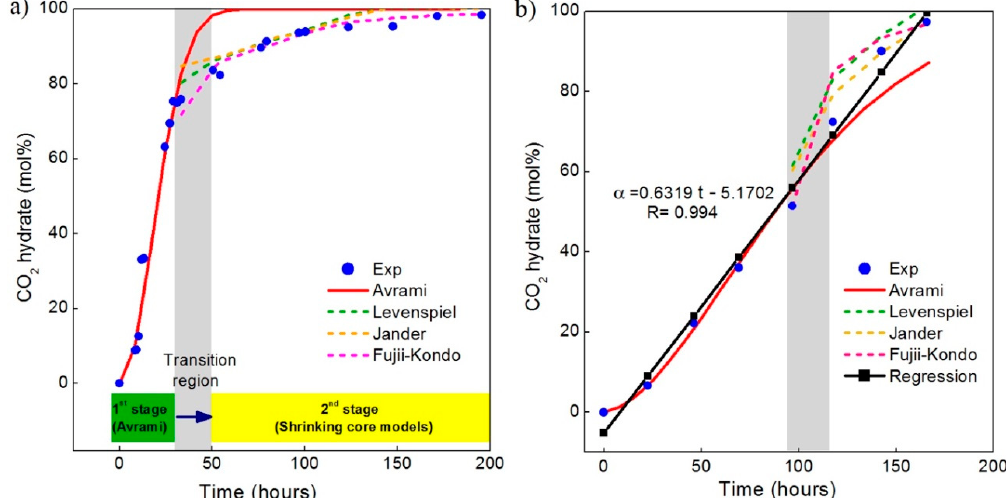
Figure 11. Comparison of the Avrami (solid line) and shrinking core models (dashed lines) with experimental data for the formation reaction of two different mixed CH 4 –CO 2 hydrate crystals: ( a ) a “survived” crystal with a remaining or growing size and ( b ) a continuously dwindling crystal. Blue dots show the experimental results taken at the surface of each crystal. The black dotted line in Figure 11b represents a linear regression for the experimental data and R is the coe ffi cient of